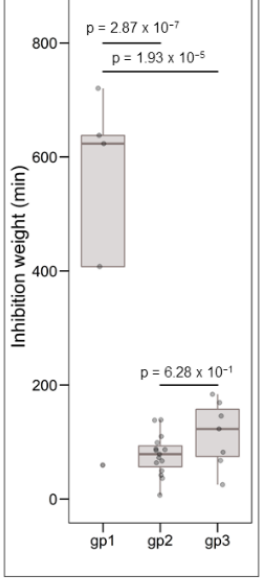
Figure 4. Boxplots representing the distribution of L. monocytogenes EGDe inhibition, the grouping variable being the group defined by hierarchical clustering (see Figure 3). The data were analysed by one- way ANOVA followed by a Tukey’s test. The resul ting p -values are indicated above the compared groups.